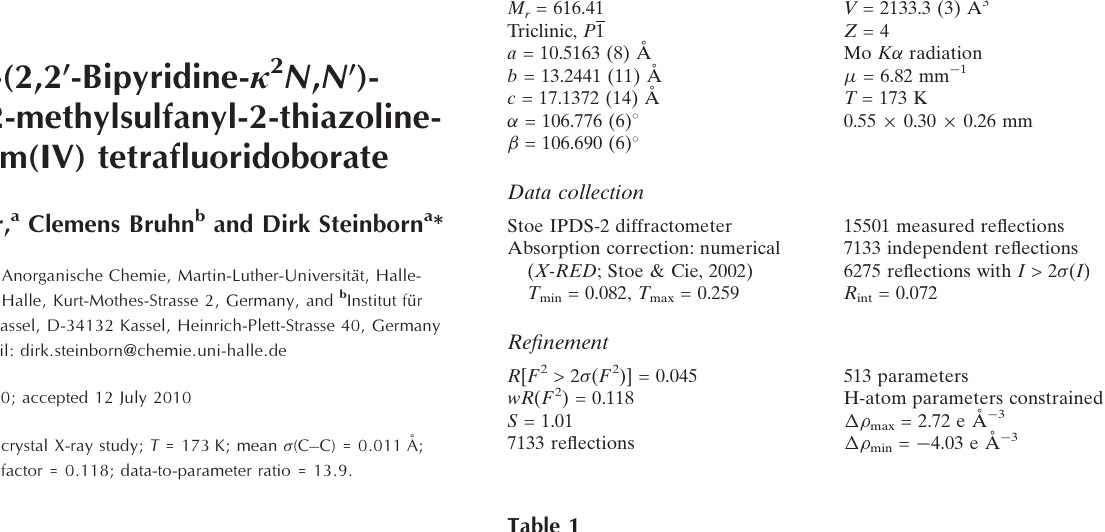
Selected bond lengths (A˚ ).